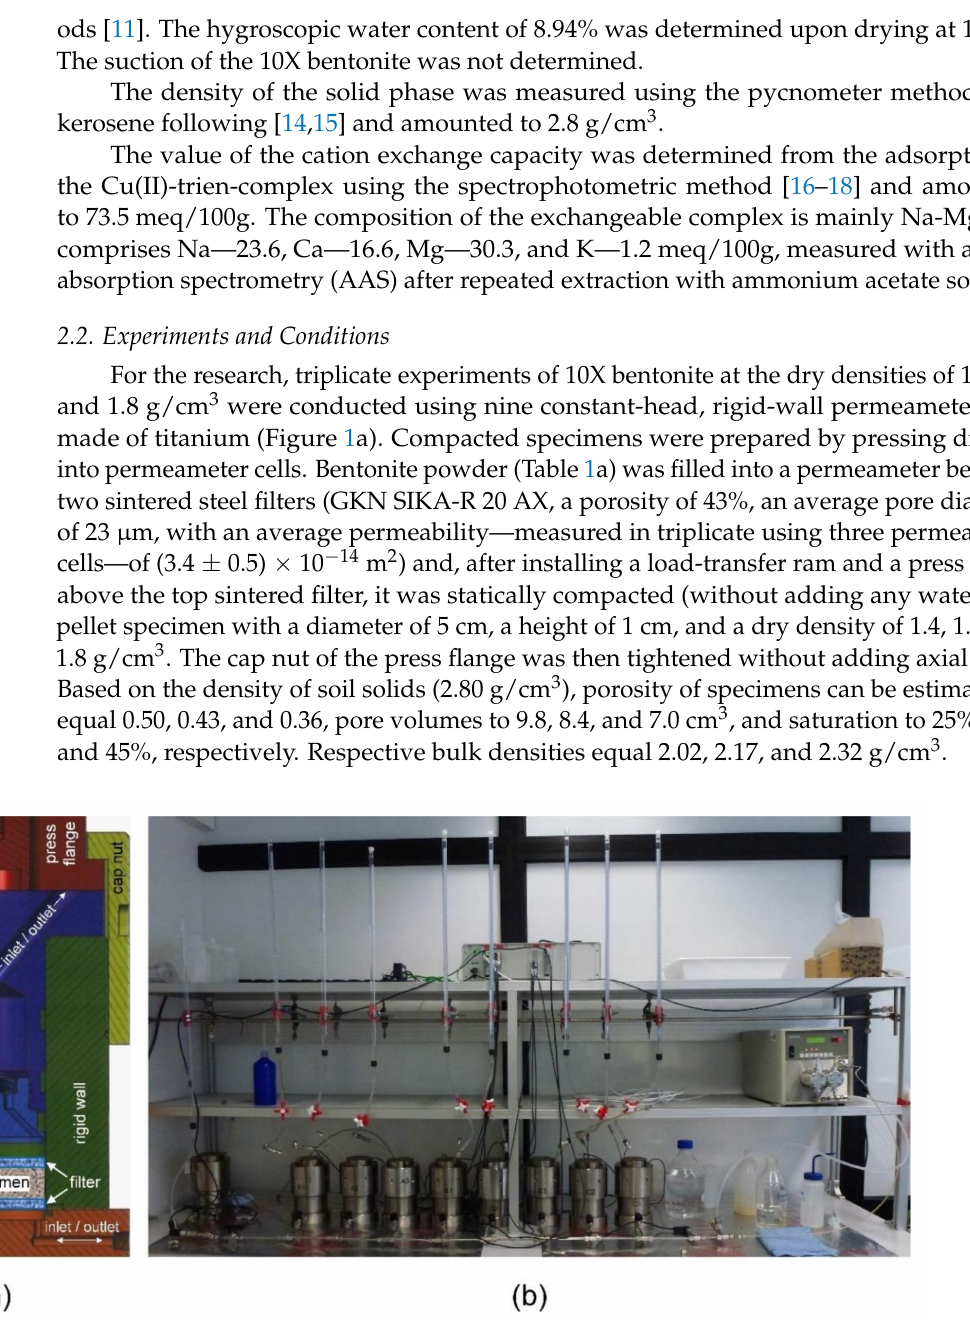
Figure 1. A construction drawing of experiments; ( a ); supply of SGW to inlets at cell bases by a piston pump; ( b ) permeability experiments (note that burettes connected to outlets at cell tops to collect percolating